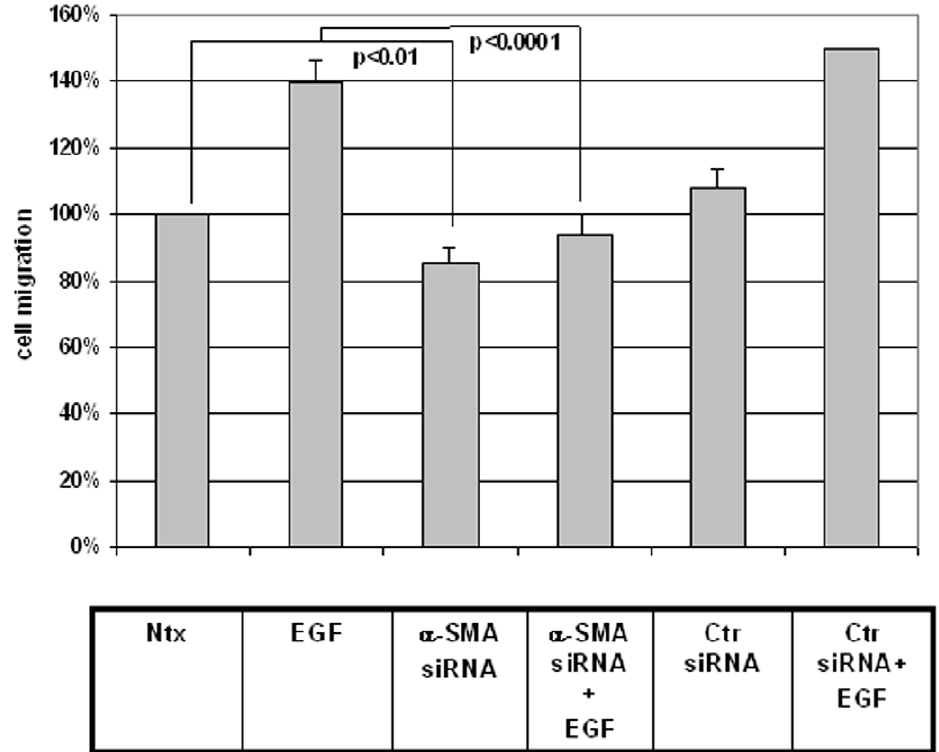
Figure 11. siRNA against a -SMA inhibits both basal and EGF-induced cell migration in adult fibroblasts. Cells were incubated in the presence or absence of EGF(1 nM) + / 2 siRNA against a -SMA in an in vitro wound healing assay. In all experiments a non-specific control siRNA was used as a control. Cell motility is displayed as a relative percentage of baseline motility in the absence of EGF or siRNA exposure (100%). Active siRNA versus a -SMA reduced both basal and EGF-induced motility; a non-specific control siRNA had no such effect. Values are means 6 SEM of eight independent studies, each performed in duplicate. Statistical analyses were performed with Student’s t test.